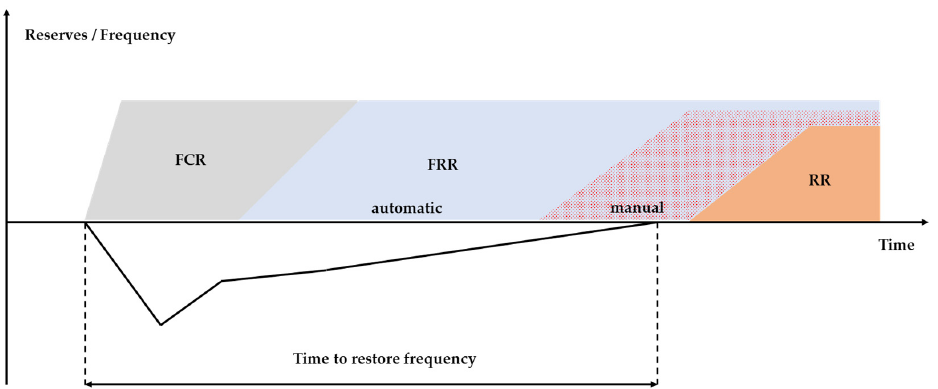
Figure 1. Load frequency control processes.